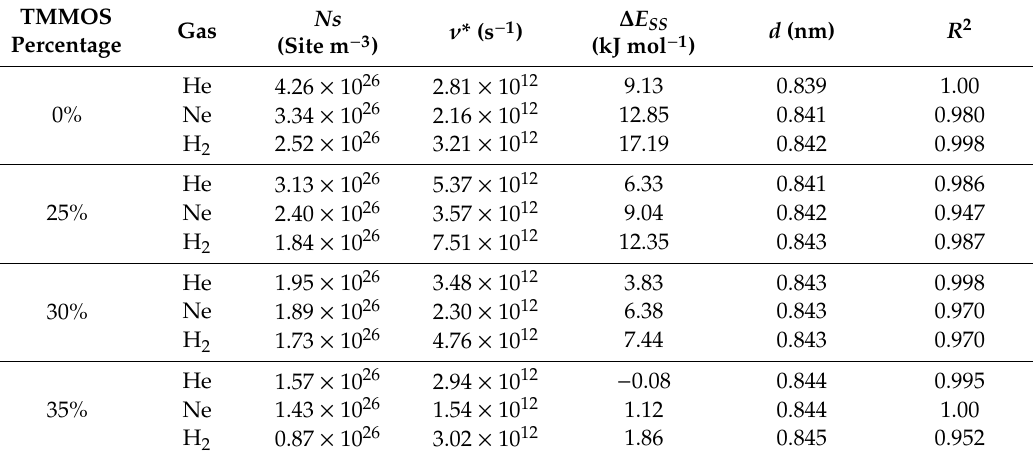
Table 2. Fitting parameter values of the solid-state diffusion model.